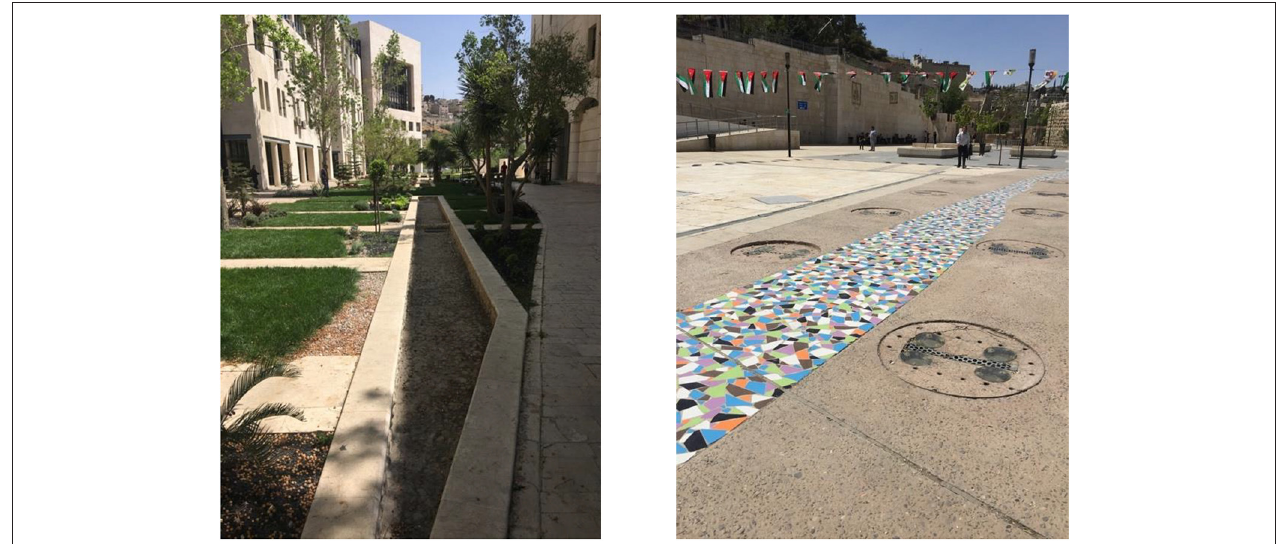
FIGURE 14 | Urban design elements that symbolize the Amman Stream, namely channels by the municipal headquarters at Ras al-‘Ain to the east (left) and coloured tiles in the Hashemite Plaza’s extension to the west (right) (photos by Dr. Luna Khirfan).